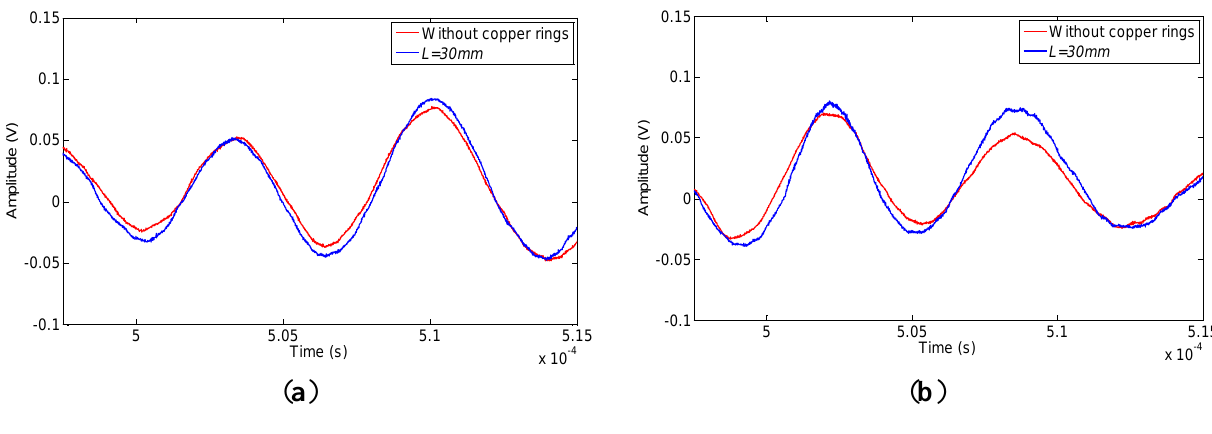
Figure 20. The comparison of defect signals obtained under ( a ) 140 kHz and ( b ) 170